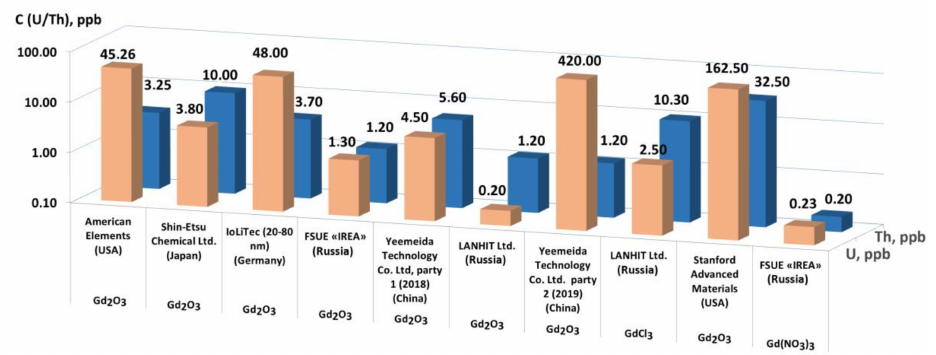
Figure 2. The determined concentration of thorium and uranium in commercial Gd-based prepara-